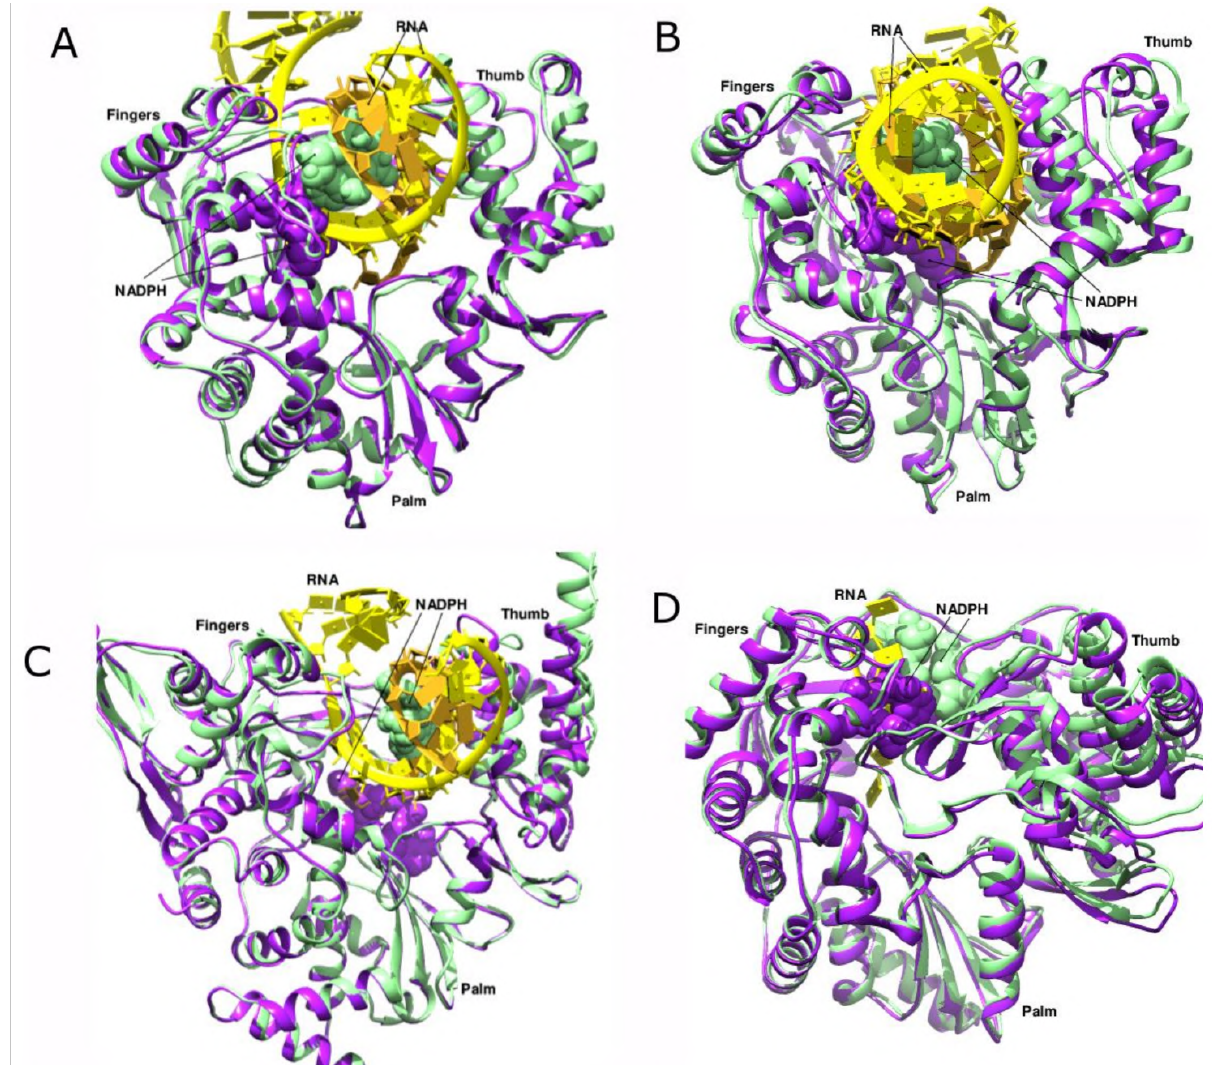
Figure 13. In silico docking of RdRP in the apo and template-bound states with NADPH. The apo form is shown in purple and the RNA-bound form is depicted in green. The polymerase is shown in ribbon representation and the ligand is shown as spheres. The RNA template and product are shown in yellow and golden colors, respectively. ( A ) EV71 (PDB 6KWQ, 3N6L) with NADPH, ( B ) PV (PDB 4K4W, 4R0E) with NADPH, ( C ) SARS-CoV-2 (PDB 7BTF, 7C2K) with NADPH, ( D ) HCV (PDB 1NB4, 1NB7) with